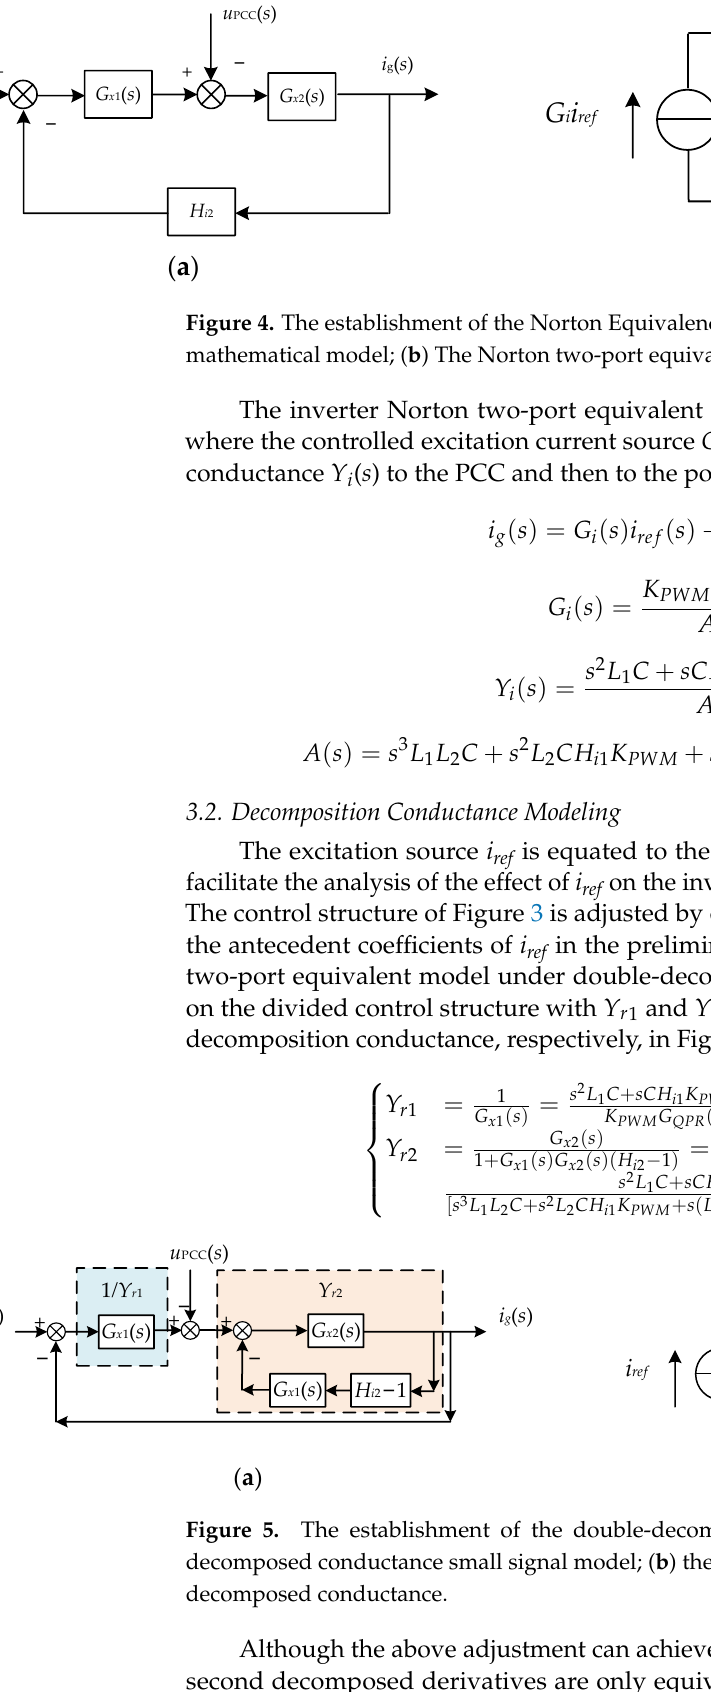
Figure 5. The establishment of the double-decomposed conductance model: ( a ) the double-decom- posed conductance small signal model; ( b ) the two-port equivalent model under the double-decom- posed conductance.